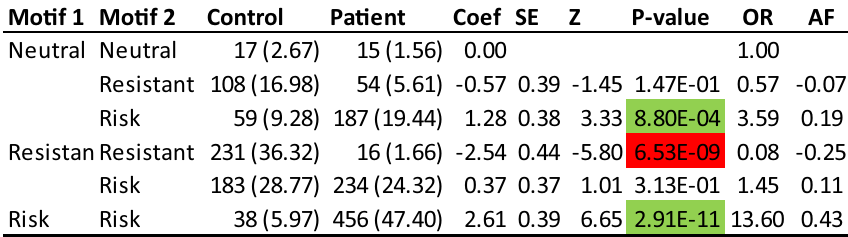
Table 7. Estimated attributable fractions for all susceptible and resistant DQ motif genotypes: genotype frequency (%) among control and patient, estimated coef, standard error, Z-score, p-value, estimated odds ratio and attribuable fraction. Notations and Conventions: As in Supplementary Fig. S1. Additional symbols are:For the putative homodimerization patch of β49-55 residues are marked with @ at the bottom of the sequence and highlighted in light green. Homodimerization of HLA-DQ has never been observed in any of the respective crystal structures. Yet, F(ab’)2 fragment of anti-HLA-DQ antibodies differentially ligate HLA-DQ molecules on the surface of human monocytes and lead to differential (compared to HLA-DR and –DP) downstream signal